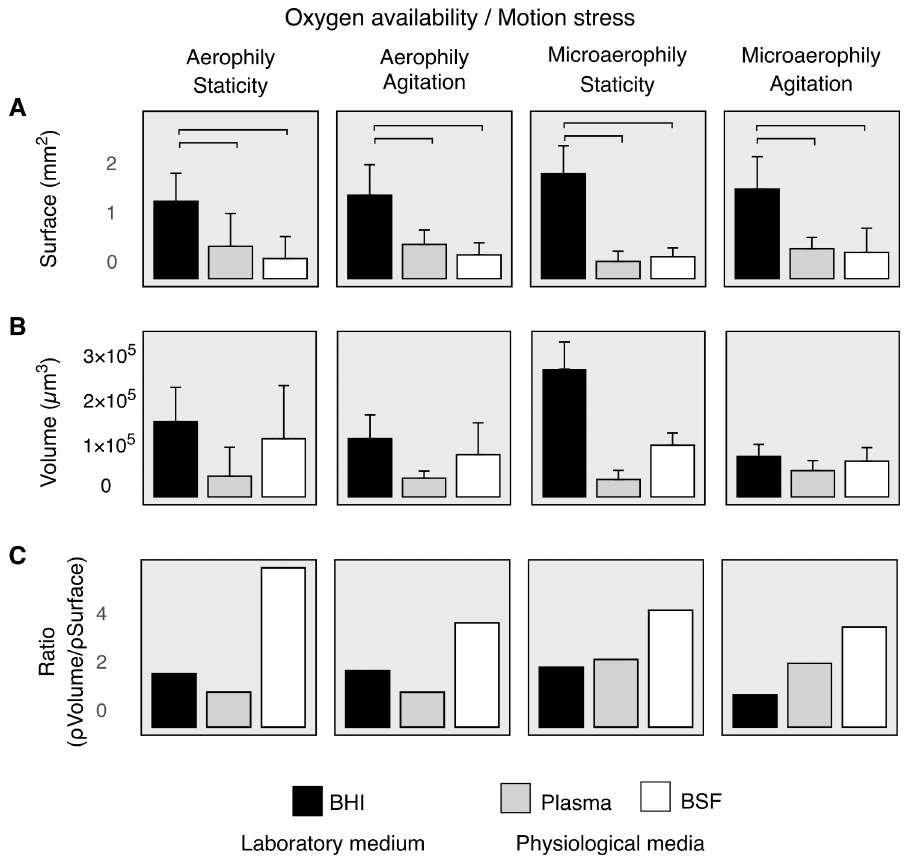
Figure 2. CLSM quantitative analysis of biofilm volume and surface on titanium disks demonstrates a reorganization of the sessile architecture and biomass distribution. ( A ) Total surface occupied by sessile biofilm on titanium disk. Horizontal lines represent statistical significance (Wilcoxon, p < 0.05). ( B ) Total volume of biofilm biomass. ( C ) Average volume/surface ratio in the different media. Black bars represent biofilm grown in laboratory medium BHI, gray and white bars represent biofilm grown in physiological fluids, respectively, plasma and